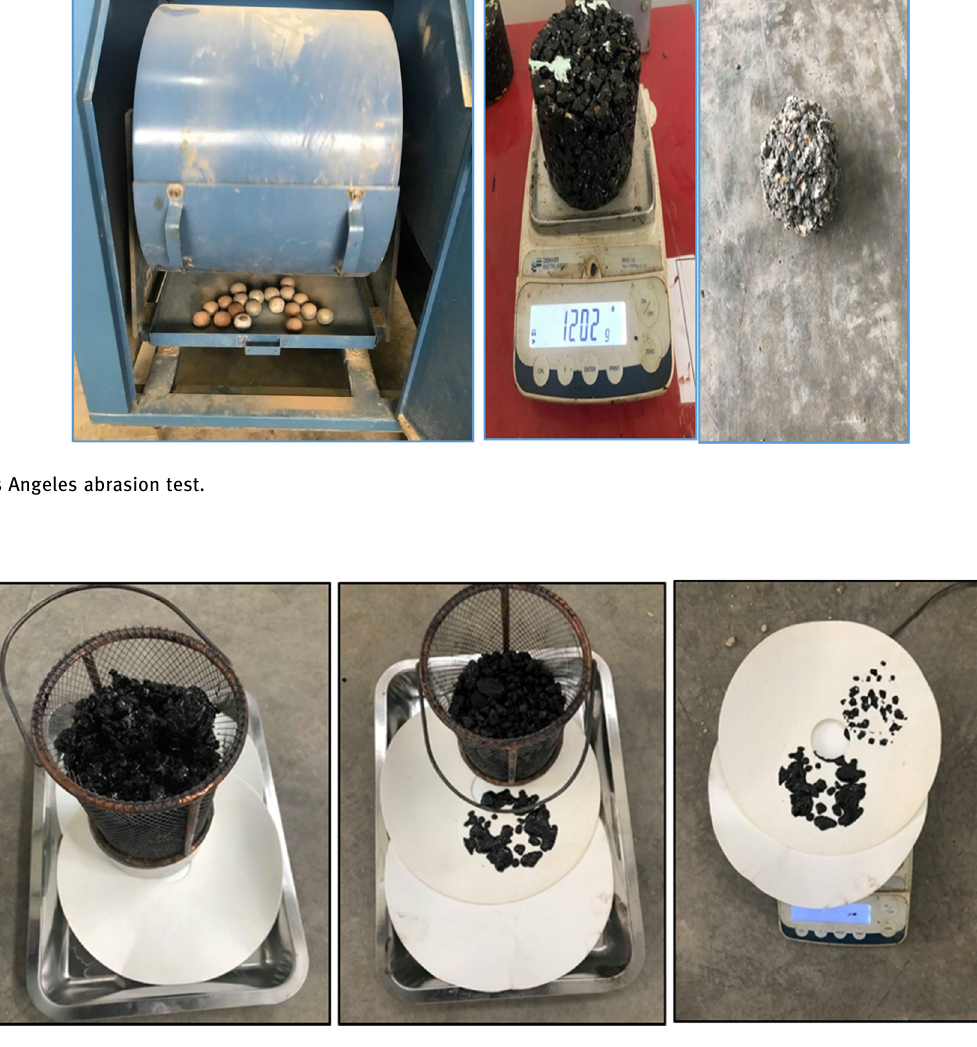
Figure 3: Asphalt drain down test for Basket before and after 1